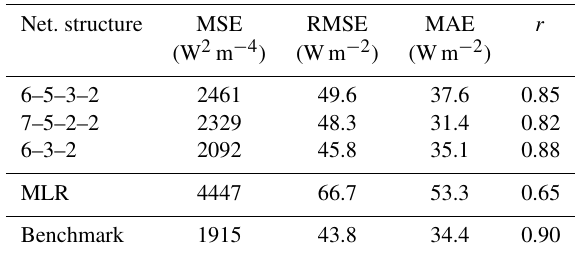
Table 6. Performance of networks vs. multivariate linear regression (MLR) and the MOST method (“Benchmark”) for heat flux at the DE-Keh station.